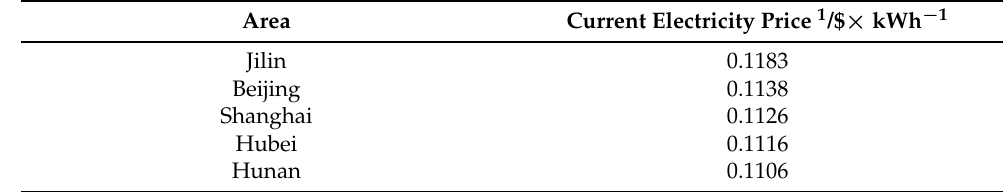
Table 4. Current electricity prices for general industrial and commercial use in various regions.